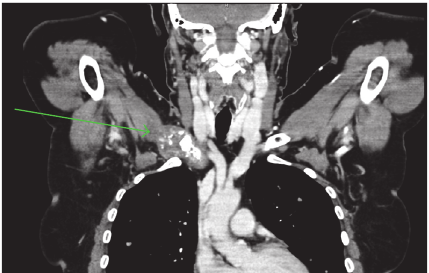
Figure4:CTscanofthorax(multiplanarreconstruction).Thegreen arrow points to osteolytic metastasis of right